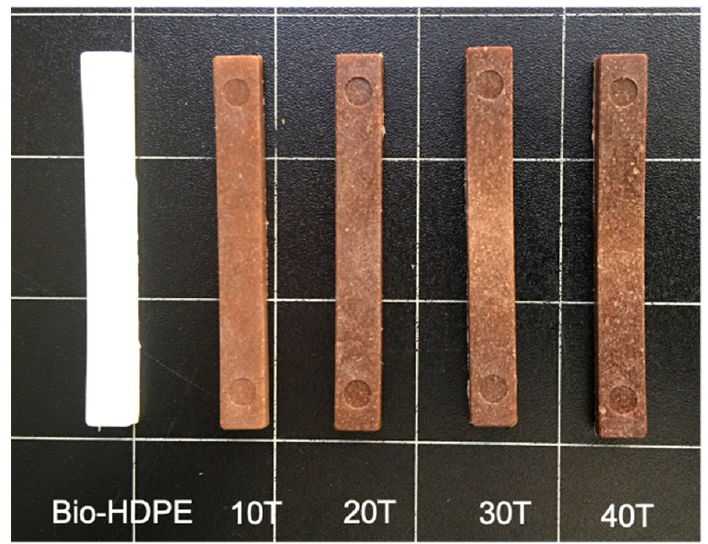
Figure 12. Visual appearance of bio-based high-density polyethylene (Bio-HDPE) with different weight percentage of treated chia seed flour with APS.